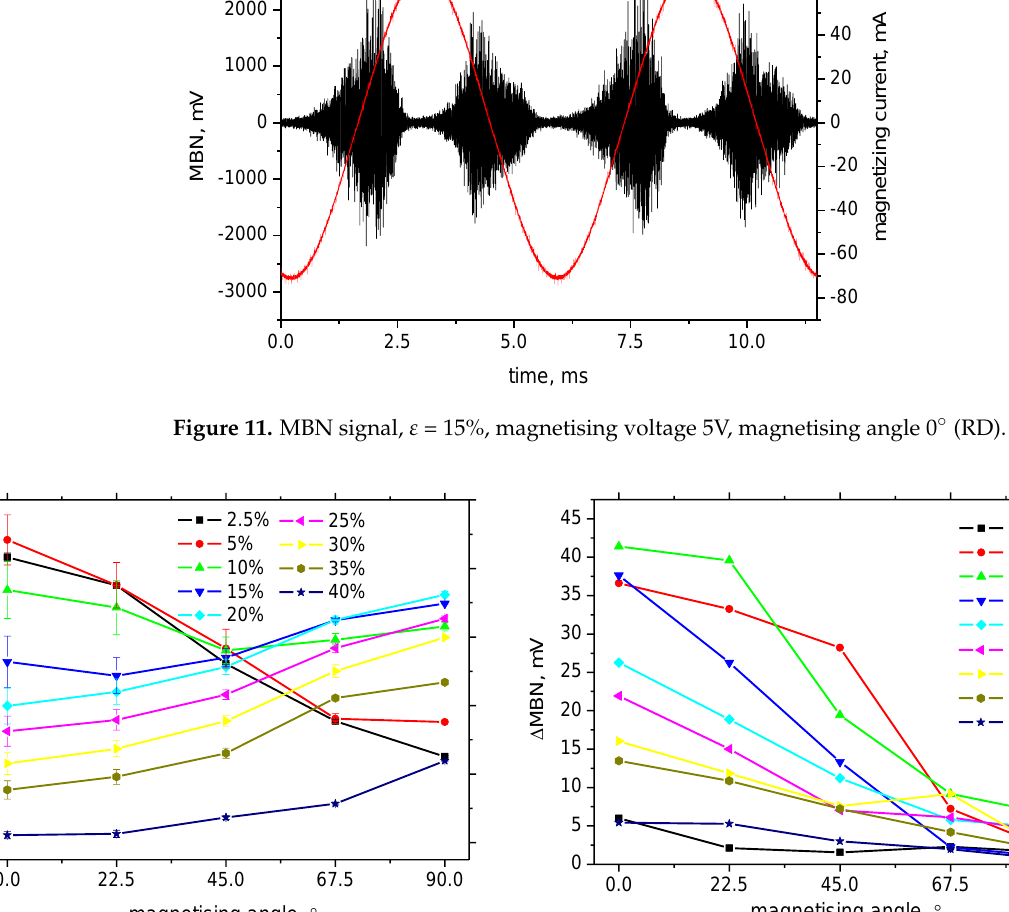
( d ) Figure 13. MBN envelopes in RD. ( a ) ε = 2.5%, 5V, ( b ) ε = 15%, 5V, ( c ) ε = 15%, 10V, ( d ) ε = 40%, 5V.